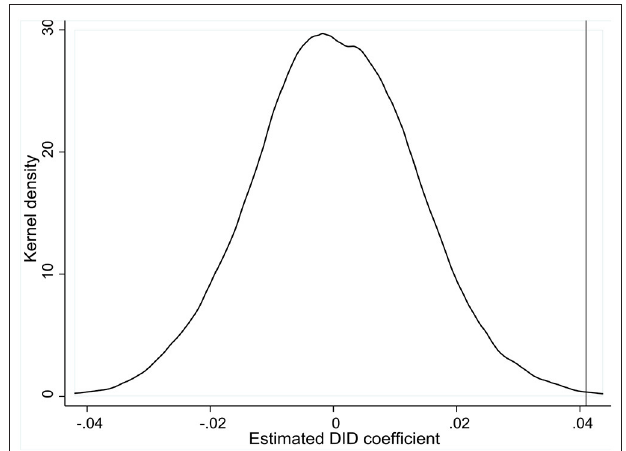
FIGURE 4 | Kernel density of estimated DID coefficients in 1,000 random permutations based on Monte Carlo simulation.